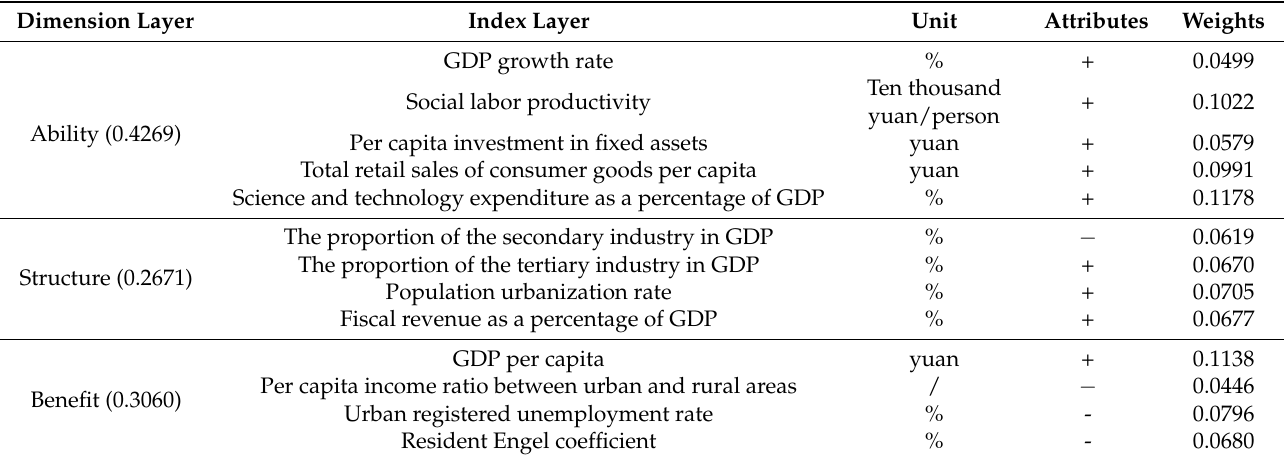
Table 1. Comprehensive evaluation index